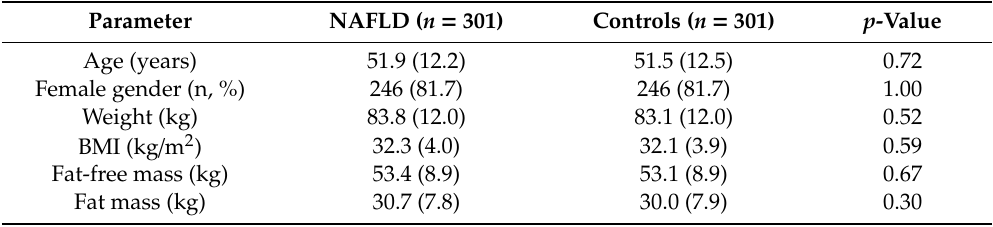
Table 1. Anthropometric parameters related to the presence or not of hepatic